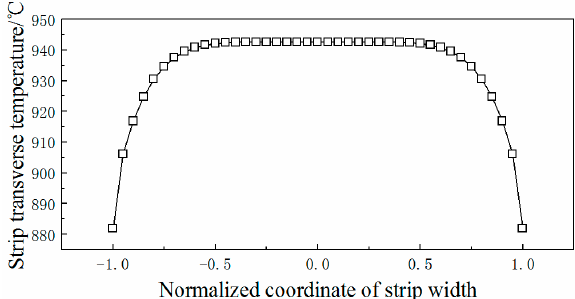
Figure 13. Lateral temperature distribution of the strip in the last stand measured by a thermal imager.